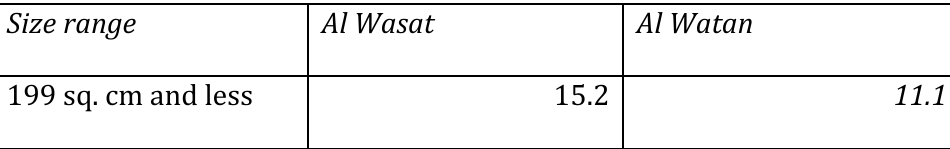
Table 2: Size of women candidate news‐items in print